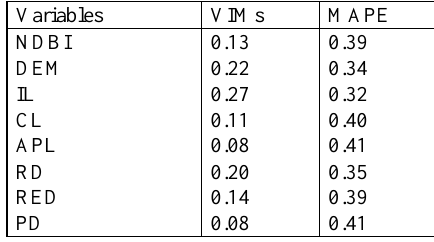
Table 3. VIMs of variables throughout the study area